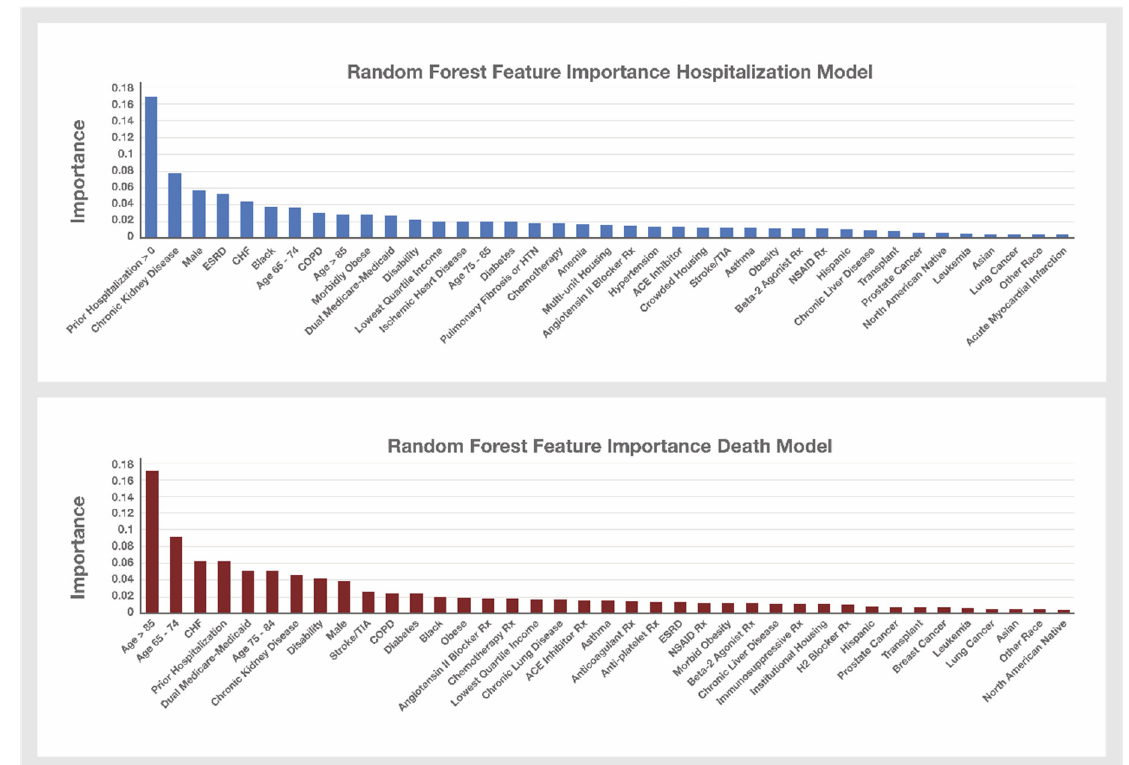
Figure 3. Random Forest Hospitalization and Death Model Feature Importance. Variables that were selected for inclusion in the Hospitalization and Death logistic regression models were used to build these two random forest models. The Feature Importance values for the variables not shown in the Hospitalization model graph are: prescriptions filled with sufficient quantity to overlap the COVID-19 diagnosis date for Azithromycin (FI 0.0104), Chloroquine and Hydroxychloroquine drugs (FI 0.0056), anticoagulant drugs (FI 0.0129), antiplatelet drugs (FI 0.0105), corticosteroids (FI 0.0118), and immunosuppressive drugs (FI 0.100); endometrial cancer (FI 0.002) or breast cancer (FI 0.006) between July and December 2019; unknown race (FI 0.0039) and HIV (FI 0.0045). The Feature Importance values for the variables not shown in the Death model graph include: prescriptions filled with sufficient quantity to overlap the COVID-19 diagnosis date for Azithromycin (FI 0.0107), Chloroquine and Hydroxychloroquine drugs (FI 0.0065), corticosteroids (FI 0.0134), anemia (FI 0.0189), unknown race (FI 0.004) and HIV (FI